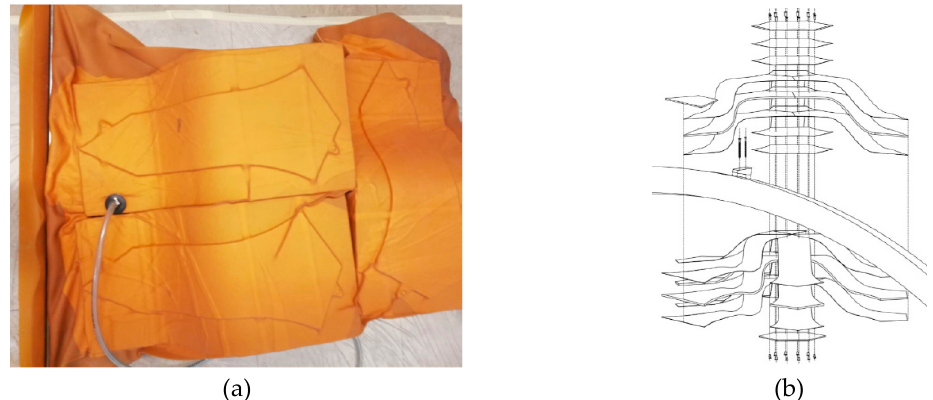
Figure 3. ( a ) Vacuum-pressing fabrication technique applied in the production of the sandwich panels using the closed molding technique; ( b ) Isometric view of single layers and connections of one of the four details of the applied modular system. © BioMat/ITKE-University of Stuttgart.